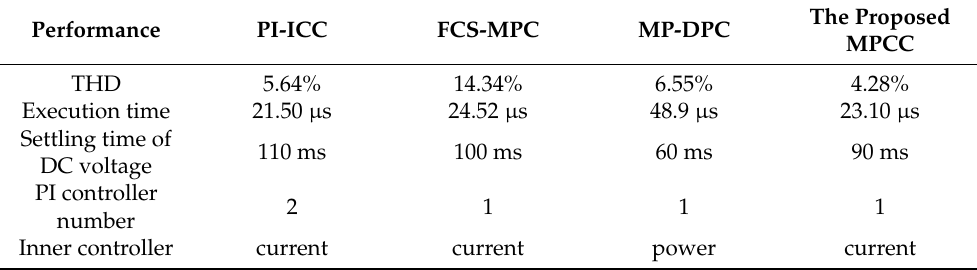
Table 6. Performances comparison of these four